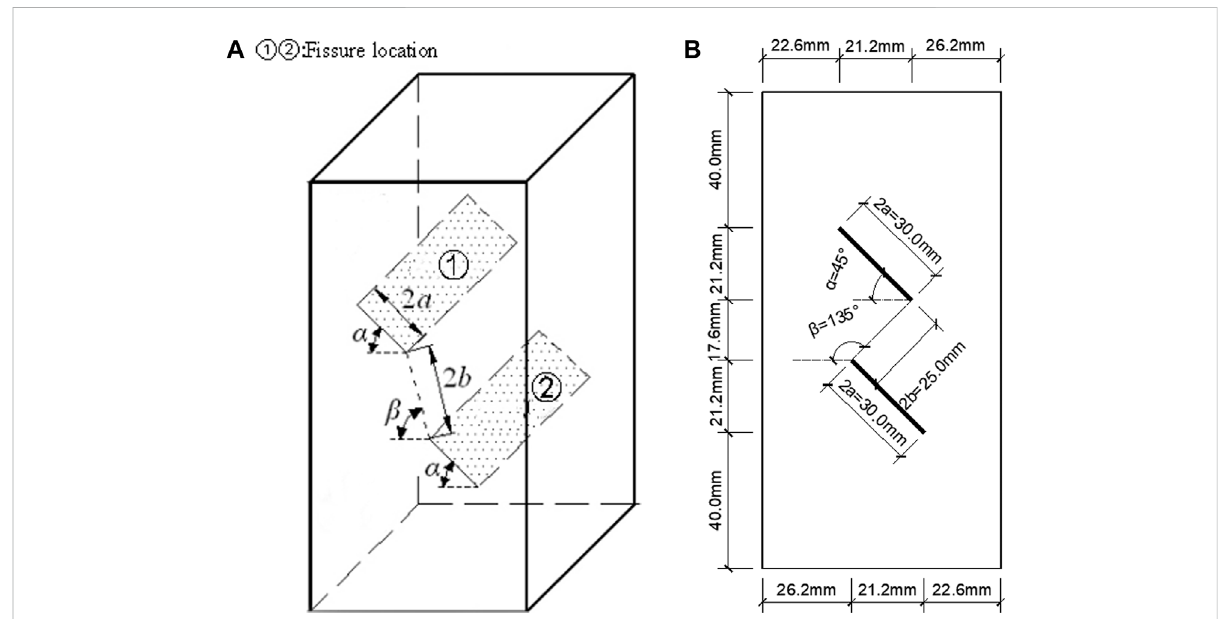
FIGURE 2 The geometric characteristics of the fi ssures. (A) Fissure stereogram. (B) Fissure size arrangement.